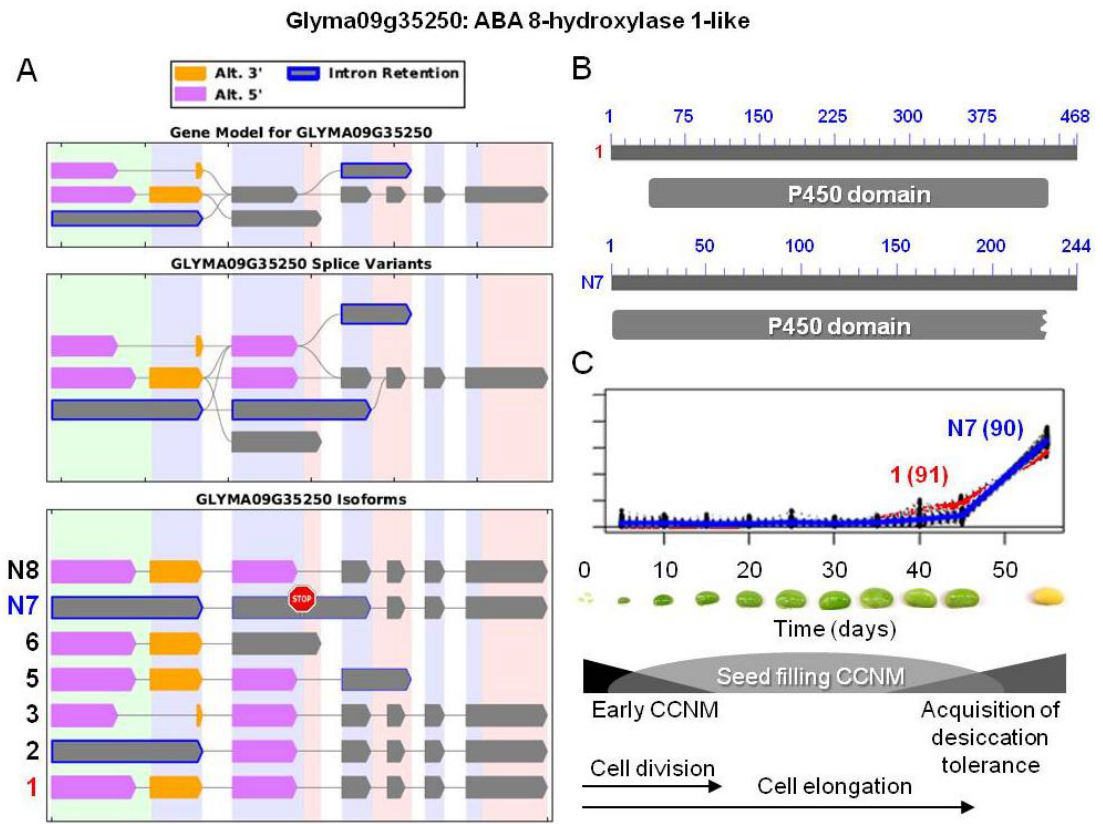
Figure 6. AS of ABA 8'-hydroxylase 1-like protein possibly involved in ABA degradation. ( A ) SpliceGrapher representations of individual isoforms detected during soybean embryo development. Alternative 3' and/or 5' splicing, and/or intron retention was observed in these isoforms. Glyma10g24590.1 and N7 corresponded to isoforms 1 and N7. The stop sign in N7 indicates a premature stop codon. ( B ) Proteins resulting from the two isoforms of interest, showing the respective positions of the p450 domains (pfam00067). Isoform N7 contains a truncated p450 domain. ( C ) Overlaid transcriptional profiles of Glyma10g24590.1 and N7 obtained from